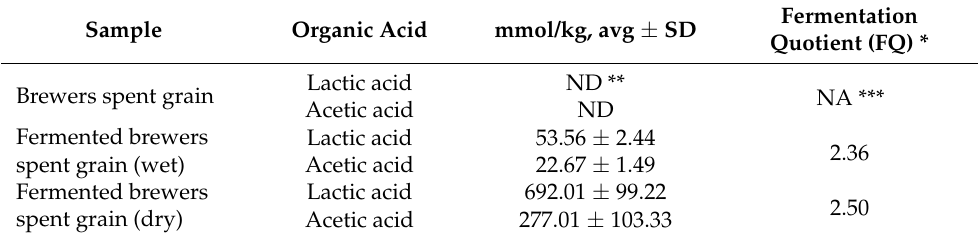
Table 1. Concentrations of lactic acid and acetic acid in fermented brewers spent